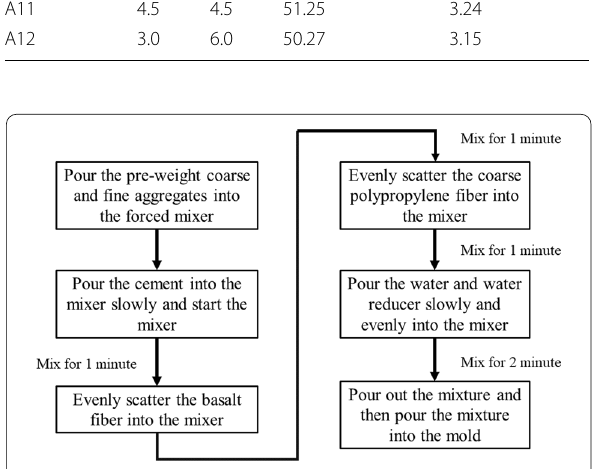
Fig. 3 Mixing procedures of